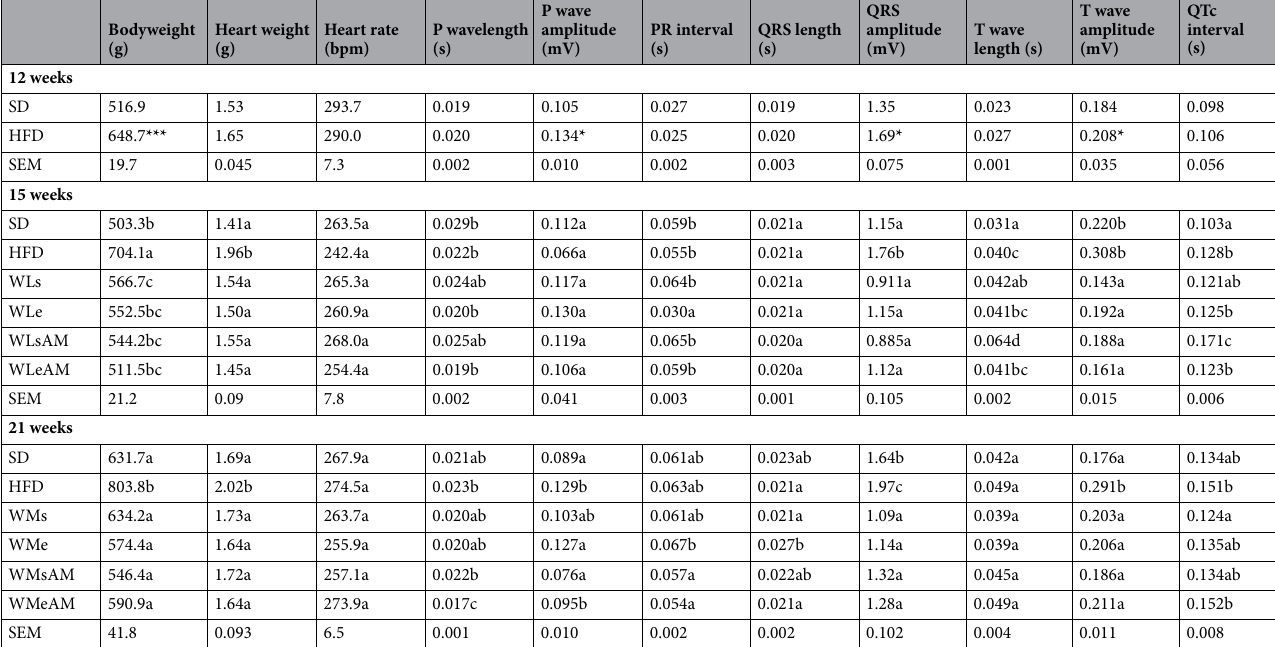
Table 1. Effects of DIO and weight control interventions on parameters of heart functionality. SD standard rat chow diet, HFD hypercaloric diet for dietary induction of obesity, WLs high protein weight-loss intervention diet with a sedentary lifestyle (weeks 12–15), WLe high protein weight-loss intervention diet with training protocol, WLsAM high protein weight-loss intervention diet with a sedentary lifestyle and pharmacological